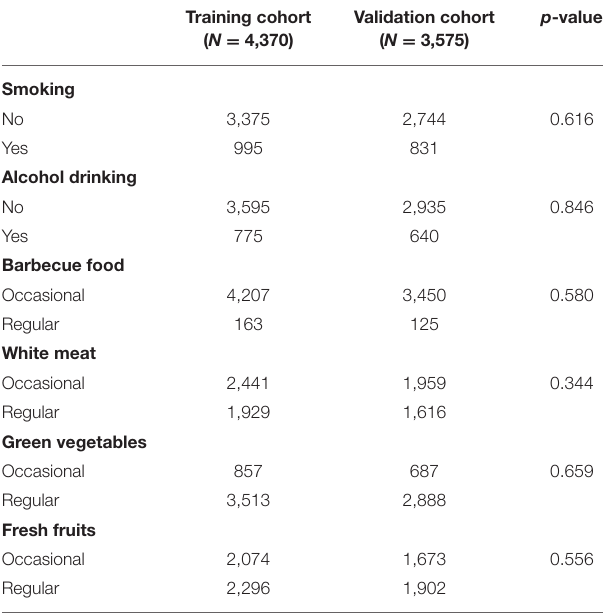
TABLE 1 | Characteristics of the validation and training